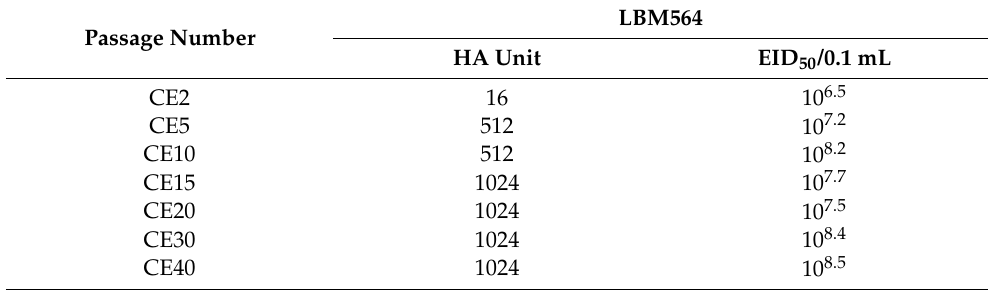
Table 1. The multiple passage of LBM564 in 9–11-day-old embryonated specific-pathogen-free eggs. Passage Number Table 2. Hemagglutination inhibition titers generated by vac564 in specific-pathogen-free (SPF) chickens. Vaccine